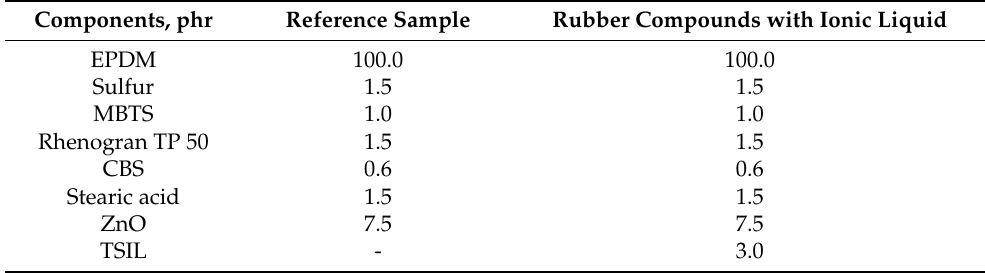
Table 3. General compositions of unfilled rubber compounds based on pure EPDM with ILs (phr). Components,